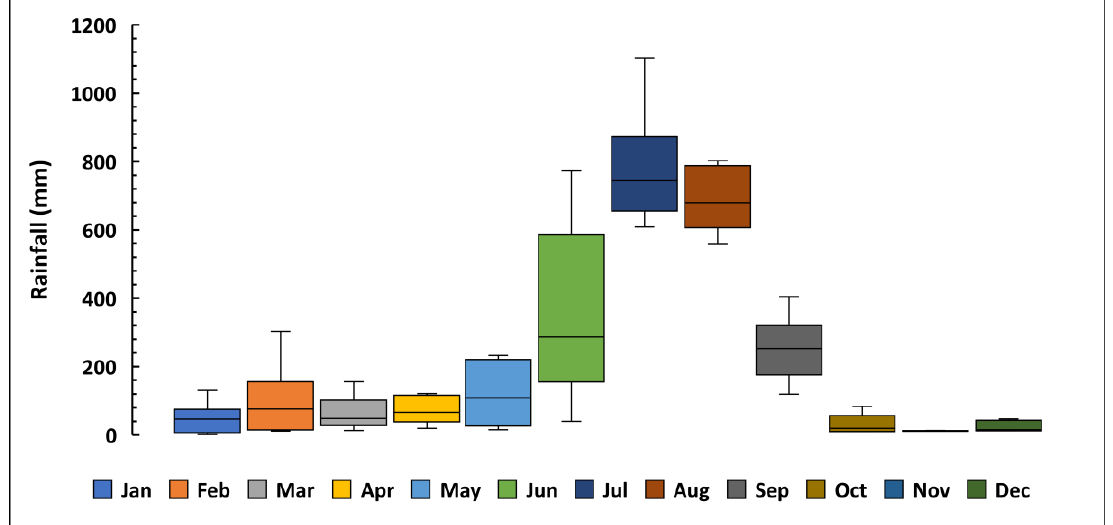
Figure 2. Rainfall pattern of the study area (IMD, 2018).